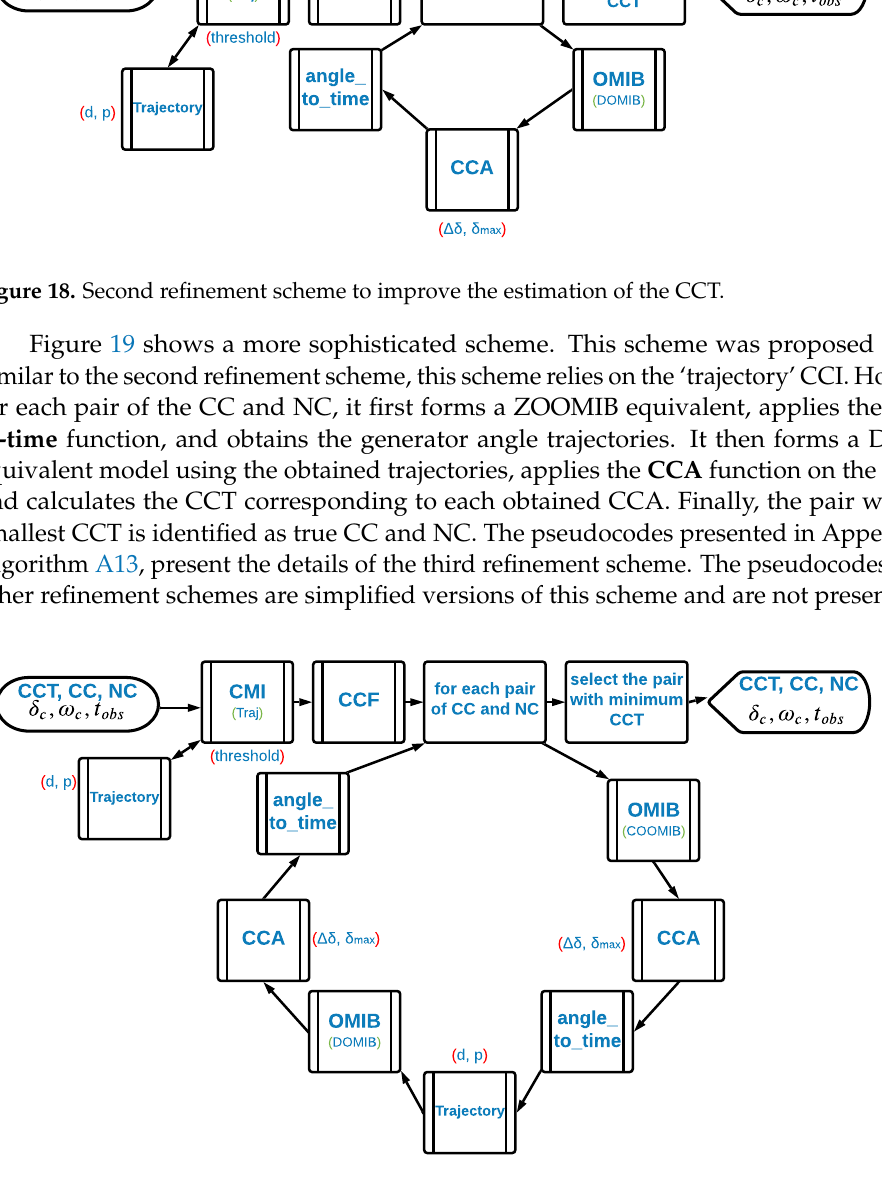
Figure 19. Third refinement scheme to improve the estimation of the